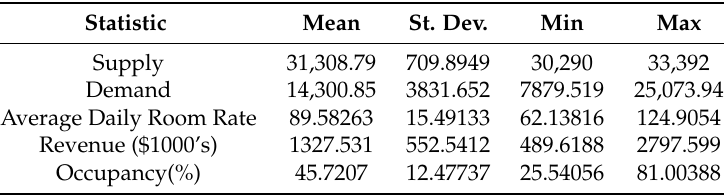
Table 4. Summary statistics, Colts